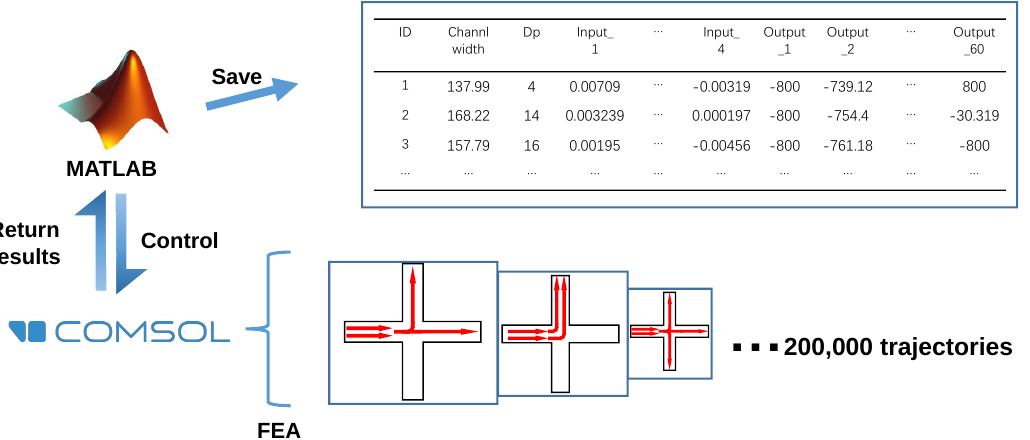
Figure 2. Data generation flow chart. MATLAB was used to automate the COMSOL simulation process. The proposed ANN is physics-informed and the schematic of ANN training is shown in Figure 3. Three dense layers were used to train the target ANN and each dense layer was a fully connected ANN, predicting part of the particle trajectory. Specifically, the first dense Input 1 had 1 × 7 parameters, which were particle diameters (Dp), channel width, the initial coordinates x0 and y0 of the particle, and the inflow rate or outflow rate of the West, North, and East ports. Output 1 was the coordinates of the first ten points of the simulated entrance trajectory (1 × 20). Input 2 for dense 2 was composed of the 7 parameters of Input 1 and 20 outputs of Output 1, which was 27 parameters (1 × 27). There were also 20 outputs at Output 2, which were the coordinates of the first ten points of the simulated middle trajectory (1 × 20). Input 3 for dense 3 was composed of the 7 parameters of Input 1 and 20 outputs of Output 2, which was 27 parameters (1 × 27) as well. Similarly, there were also 20 outputs at Output 3, which were the coordinates of the first ten points of the simulated exit trajectory (1 × 20). The 1 × 20 parameters at Outputs 1, 2, and 3 provided the total 1 × 60 outputs. The three dense layers were three fully connected ANNs, and the complete particle trajectory was obtained by piecing the entrance, middle, and exit trajectories. A more detailed configuration of the dense network in the proposed ANN can be found in Table 1. The training process was implemented in Python 3.10 with the help of PyTorch. The loss during the training process was calculated using mean squared error (MSE), and the accuracy rate was determined by using R